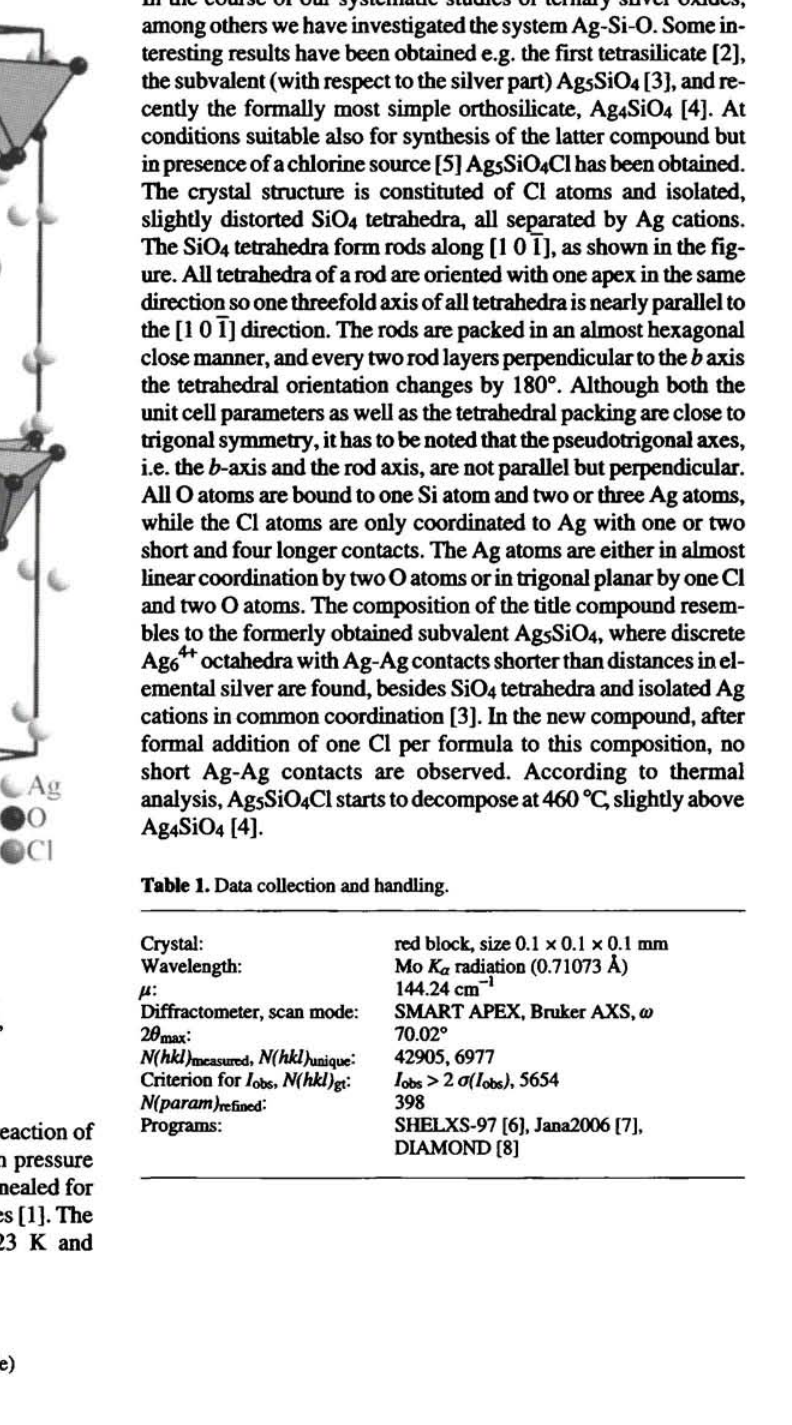
Table 1. Data collection and